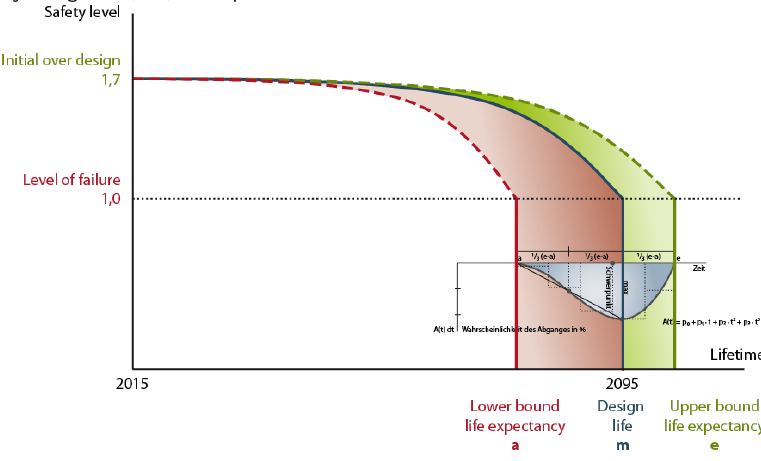
Figure 3. Mathematical formulation of degradation as specified by EN